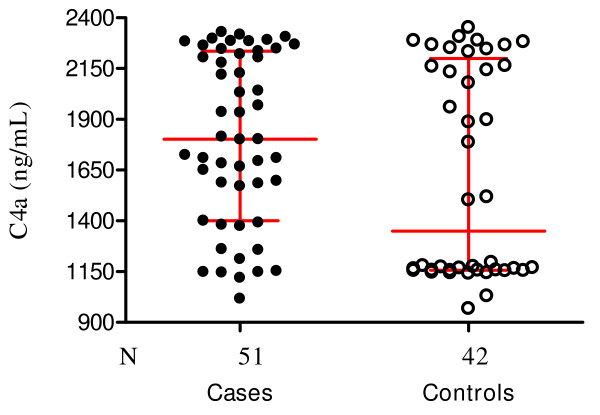
Scatter plot showing the median and interquartile C4a levels in children with severe malaria anaemia (cases) and those with uncomplicated malaria (controls). The median C4a levels in cases was 1,800 ng/mL (1,400–2,200) and 1,350 ng/ml (1,160–2,200) in the controls (P = 0.08). Wilcoxon matched-pairs signed-ranks test was performed with the 42 paired samples.